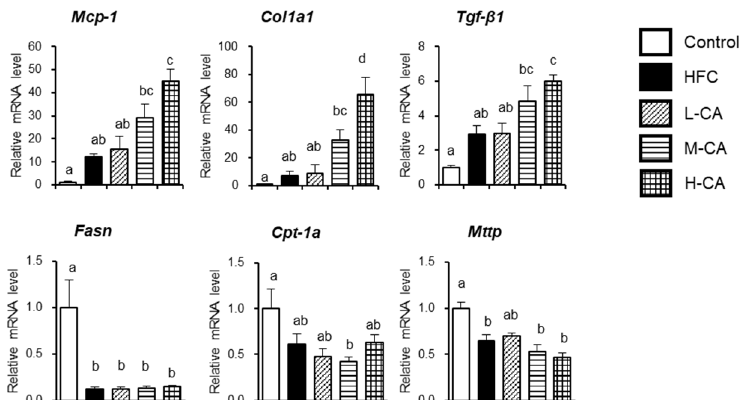
Figure 3. Hepatic gene expression involved in inflammatory response, fibrogenesis, and lipid metabolism in the control, HFC and L-CA, M-CA and H-CA groups. The levels of mRNA were expressed relative to the control group. Values are expressed as means ± SE; n = 5–6/group. a,b,c,d values not sharing the same lowercase letter are significantly different among groups ( p < 0.05). HFC, high-fat and high-cholesterol; L-CA, M-CA and H-CA, the HFC diet with 0.1%, 0.5% and 2.0% sodium cholate ( w / w ), respectively; Col1a1, procollagen type I, alpha 1; Cpt-1a, carnitine palmitoyltransferase-1a; Fasn, fatty acid synthase; Mcp-1, monocyte chemotactic protein-1; Tgf- β 1, profibrotic marker transforming growth factor- β 1.